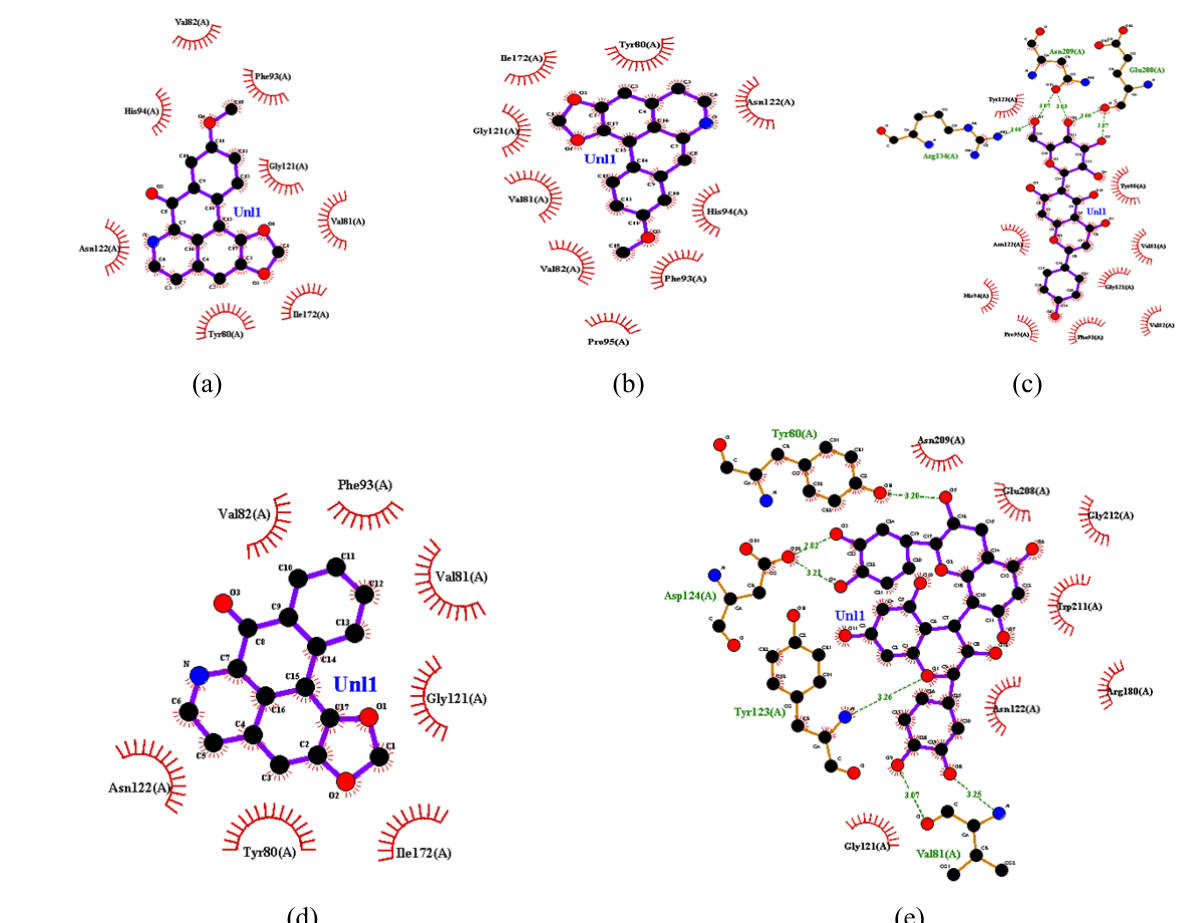
Figure 4. 2D visualization in LigPlot + 2.2 (by EMBL's European Bioinformatics Institute) to show the interaction between ricin and (a) lanuginosine; (b) xylopine; (c) isovitexin; (d) liriodenine; and (e) procyanidine, as virtual screening result using AutoDock